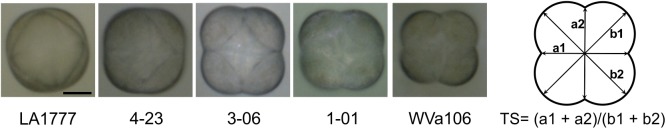
The type VI trichome heads of the parental lines LA1777 and WVa 106 as well as representative backcross lines with intermediate scores as observed with a bright field microscope. Scale bar is 20 μm. The right panel shows the formula to calculate the trichome score (TS).